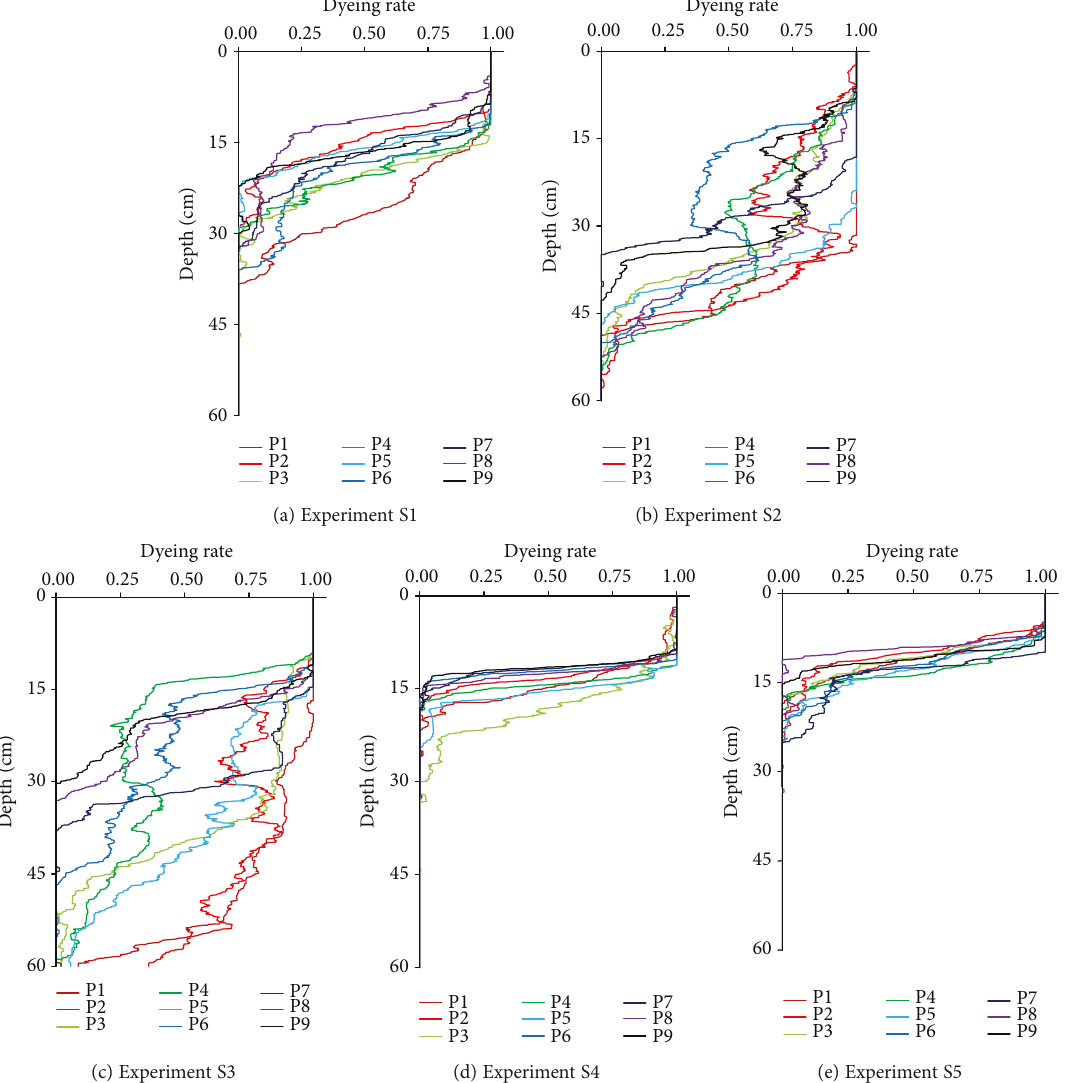
Figure 6: The amount of stained area per depth (dye coverage) in di ff erent experiments; P1 to P9 represent sections 1 to